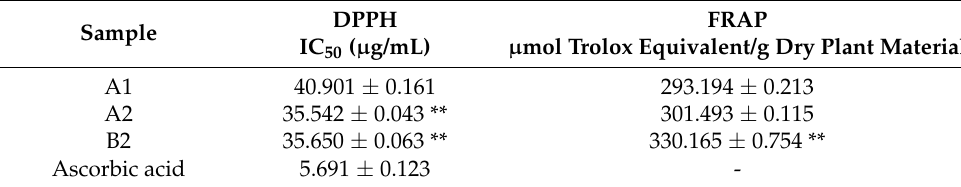
Table 3. Antioxidant activity of D. moldavica